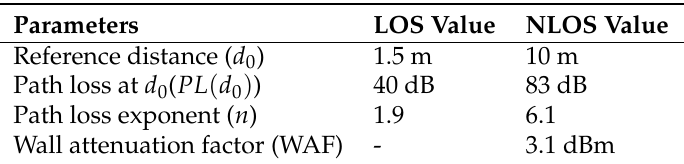
Table 2. Tmote Sky signal propagation measurements [12].